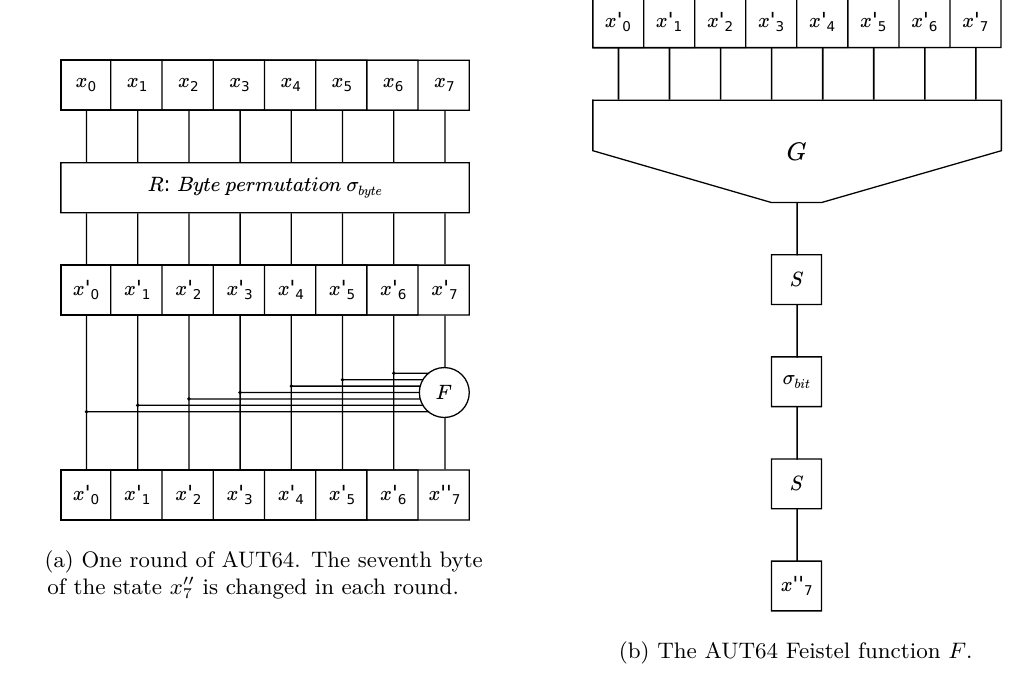
Figure 2: The AUT64 Feistel network construction (a) and Feistel function